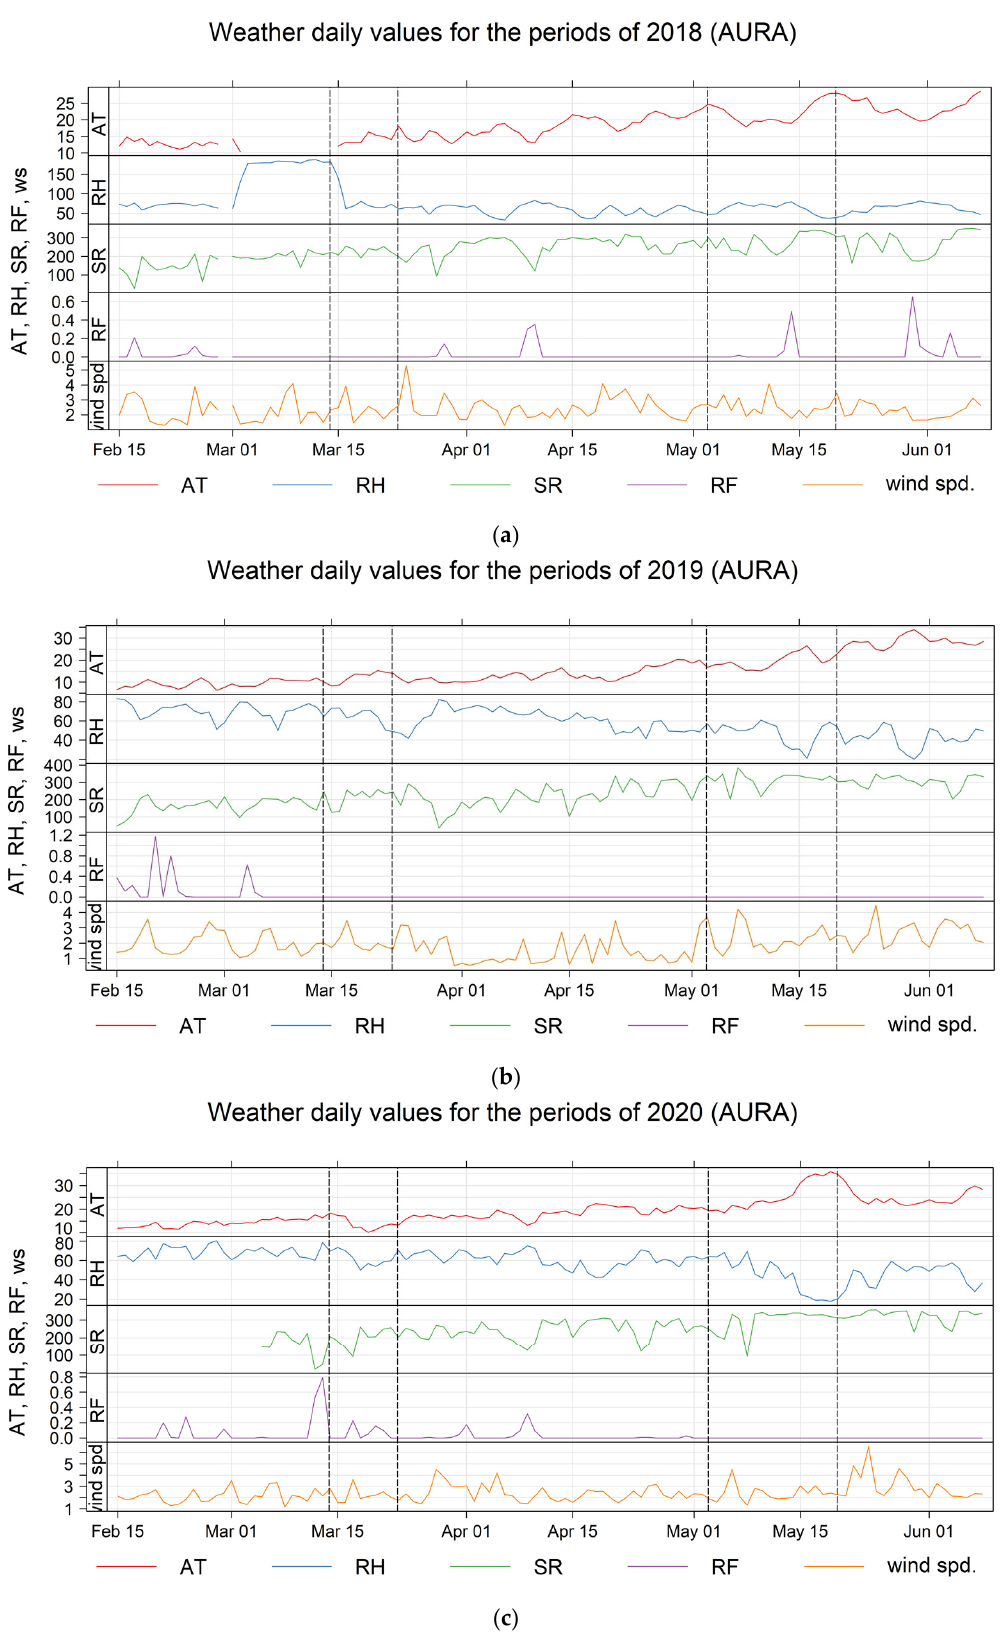
Figure 10. The time series of the daily mean values of ambient temperature (AT), relative humidity (RH), solar radiation (SR), rainfall (RF) and wind speed (WS) for the study period of ( a ) 2018, ( b ) 2019 and ( c ) 2020 at AURA